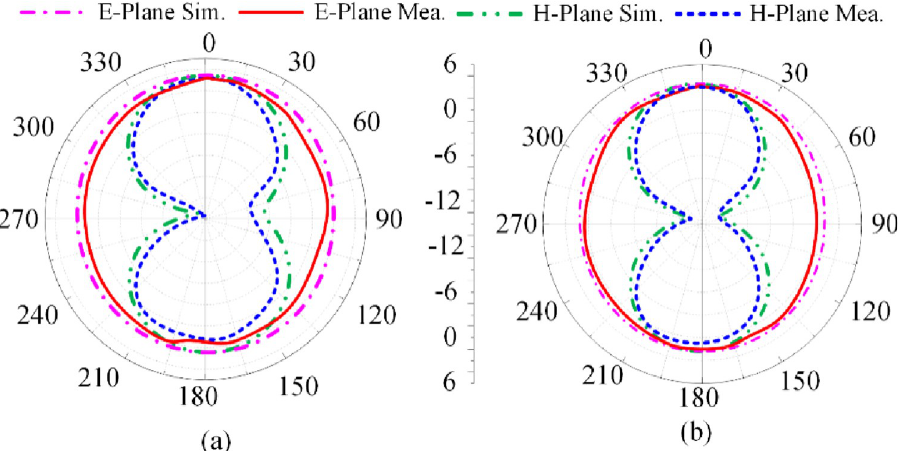
Fig 9. Radiation pattern of proposed antenna when PIN diode D1 is forward biased and D2 is reverse biased at (a) 3.5 GHz, and (b) 4.8